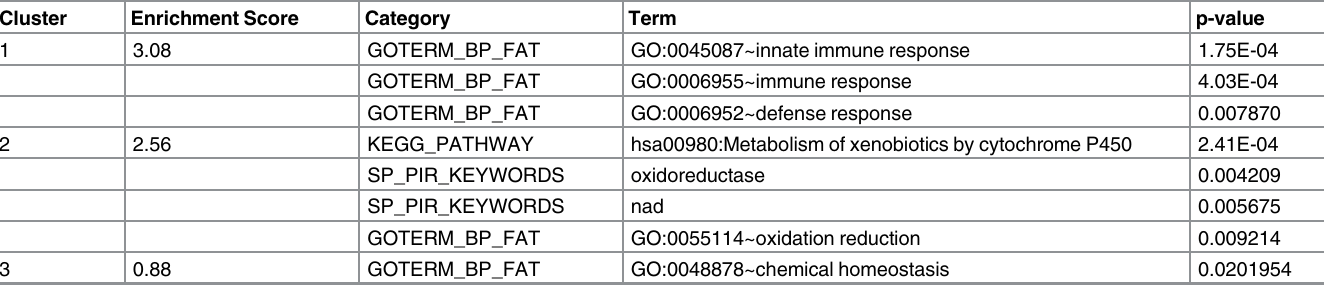
Table 3. Selection of DAVID functional annotation clustering of up-regulated genes.